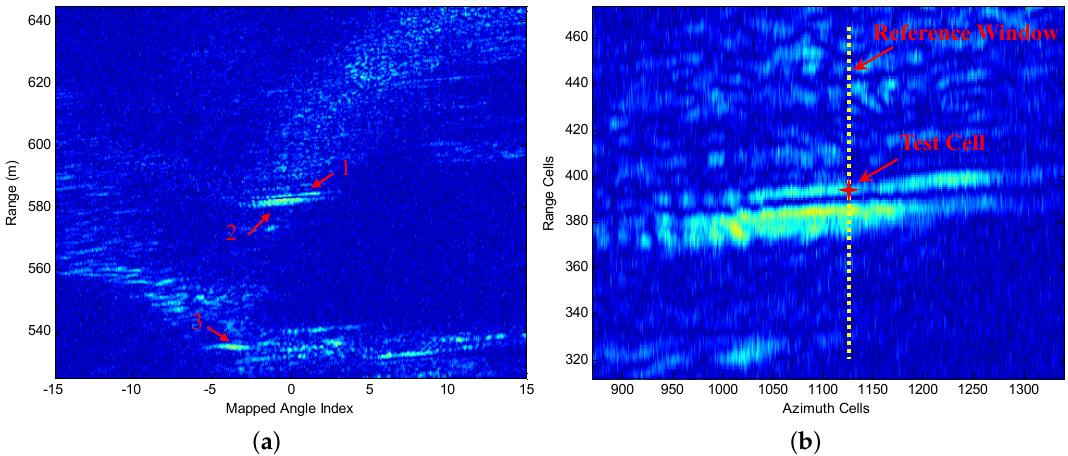
Figure 16. Two styles of zoom-in views of the radar data matrix: ( a ) B-scope image display of the data matrix; ( b ) Zoom-in view of Target 1 and Target